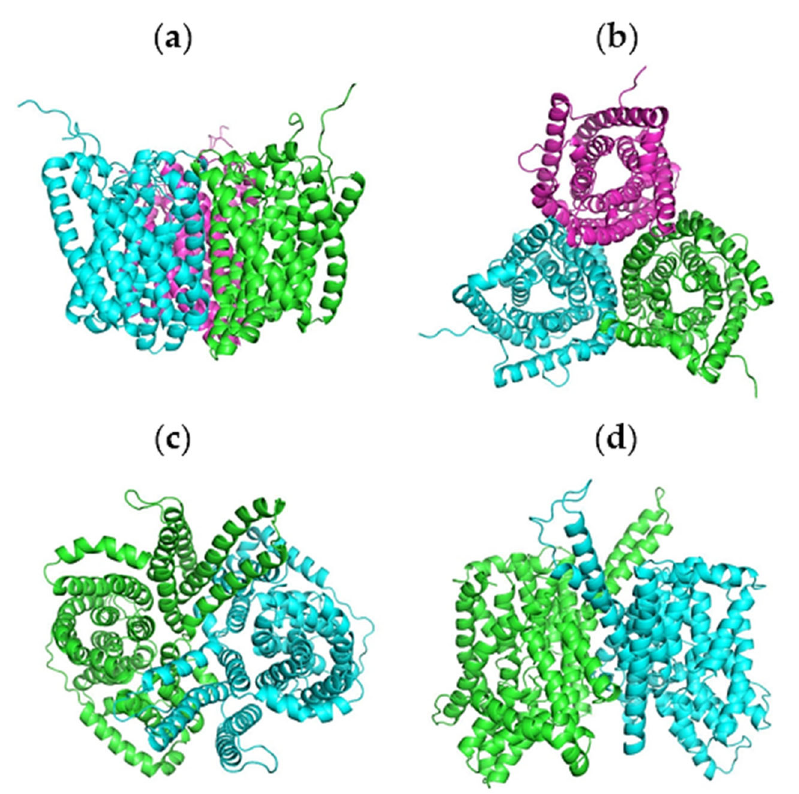
between these sub-units (as shown in Figure 3). these sub-units (as shown in Figure 3).